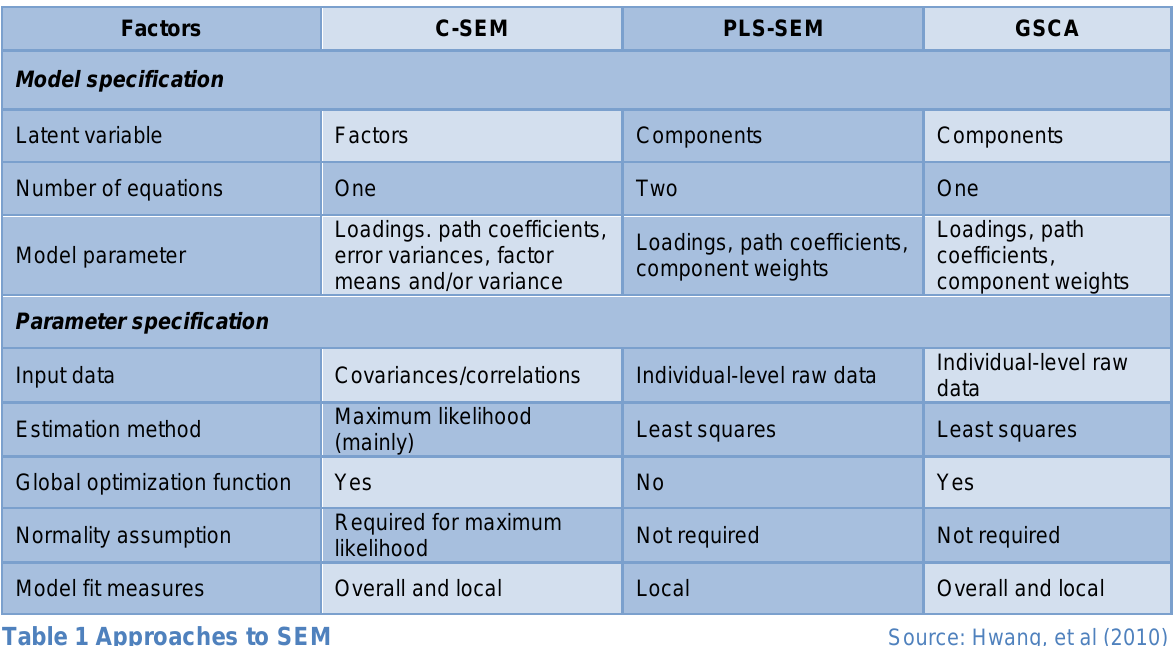
Table 1 Approaches to